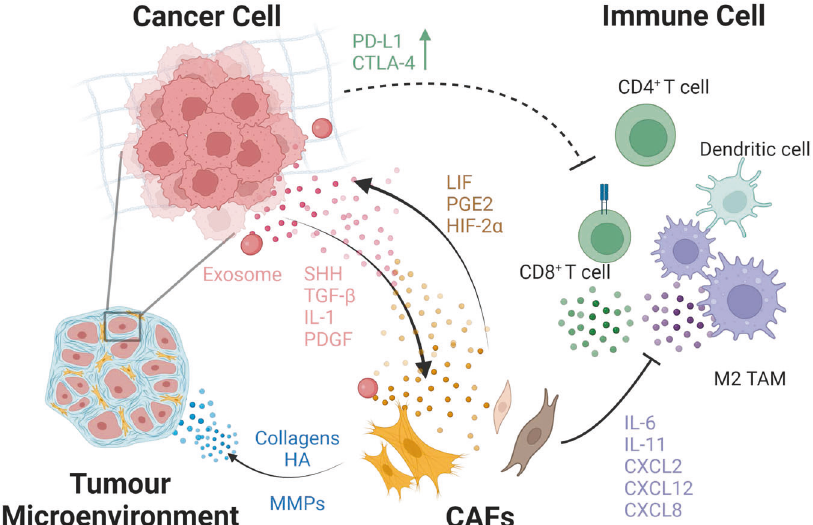
Fig. 2 The crosstalk between CAFs, cancer cells and immune cells. CAFs secrete ECM components and contribute to the fi brotic tumour microenvironment. Cancer cell-derived cytokines such as SHH, TGF- β , IL-1, PDGF, and HIF-1 are important in CAF activation, and activated CAFs promote cancer cell proliferation by secreting pro-tumourigenic factors. Furthermore, exosomes released by PDAC cells can aid in the recruitment and activation of CAFs. Pancreatic CAFs contribute to the formation of the inhibitory immune microenvironment by secreting factors such as IL-6, CXCL2, CXCL12, and CXCL8. CAFs are not only responsible for the recruitment and regulation of immunosuppressive cells, but also prevent CD8 + T cells from performing anti-tumour functions by upregulating immune checkpoint